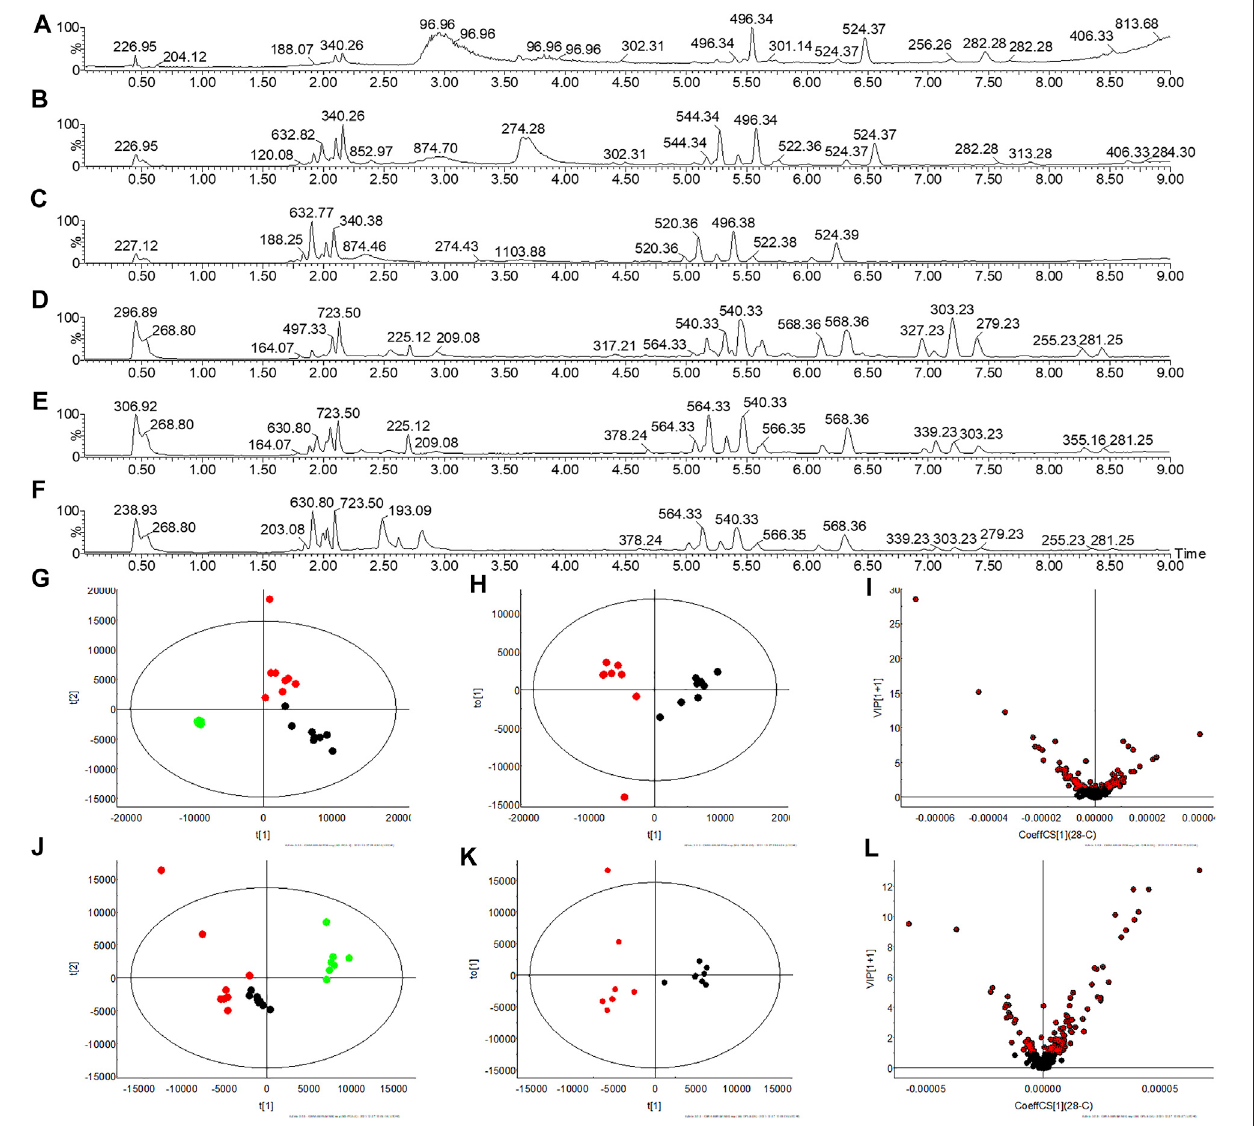
FIGURE3| Serummetabolicpro fi lecollectionandmultivariatestatisticalanalysis. (A – C) TICspectraofC,M,andTratsinESI + ,respectively (D – F) TICspectraofC, M,andTratsinESI − ,respectively (G , J) PCAplotofC,M,andTinESI + andESI − ,respectively (H , K) OPLS-DAplotofCandMinESI + andESI − ,respectively (I , L) VIPplot of C and M in ESI + and ESI − , respectively. Note: : C rats; : M rats; : T rats.